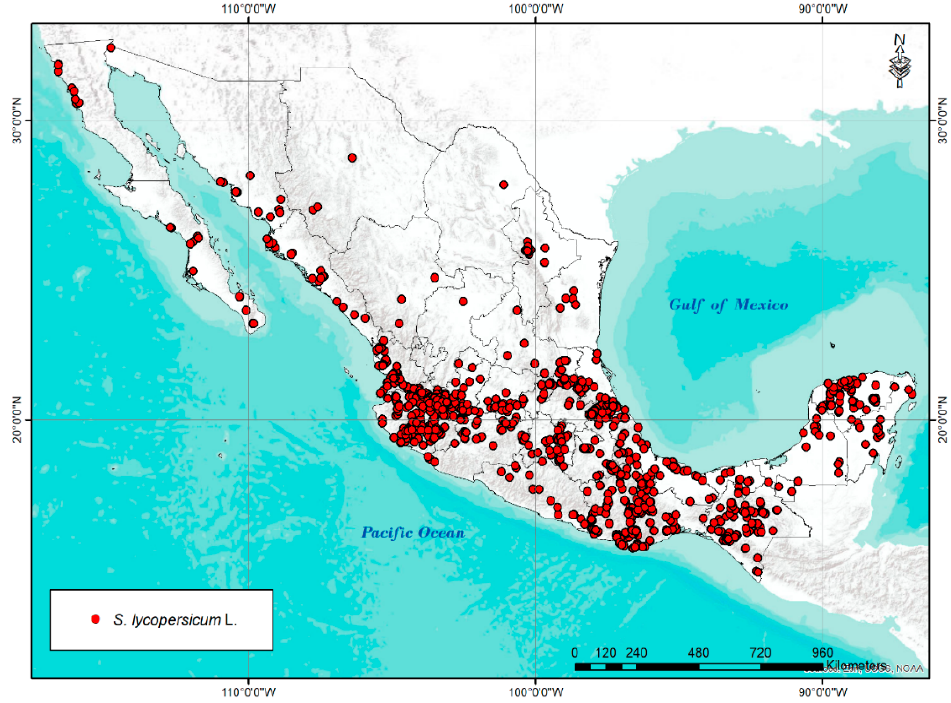
Figure 7. Geographical distribution of 1296 collections of S. lycopersicum L. in Mexico.